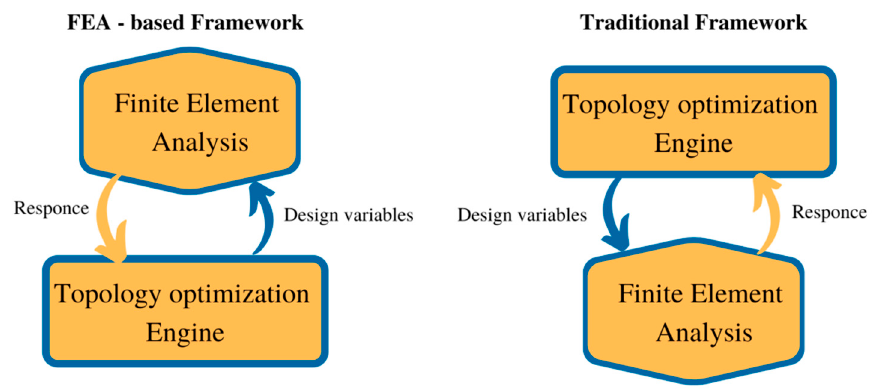
Figure 1. Topology optimization framework comparison.